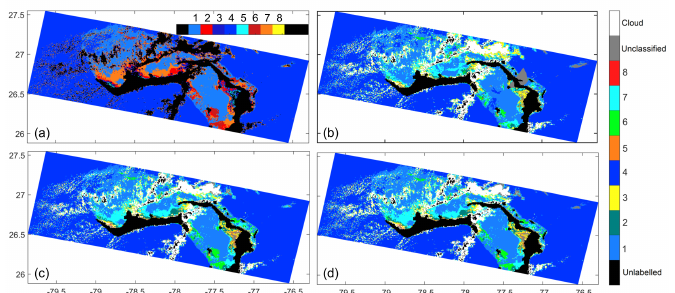
Figure 10. Classification of MERIS data from scene A shown in Figure 9—( a ) the classification result in Figure 9 but with a different color map; ( b – d ) classification using nearest cloud Opt proximity Opt , and all clouds Opt , respectively. proximity all